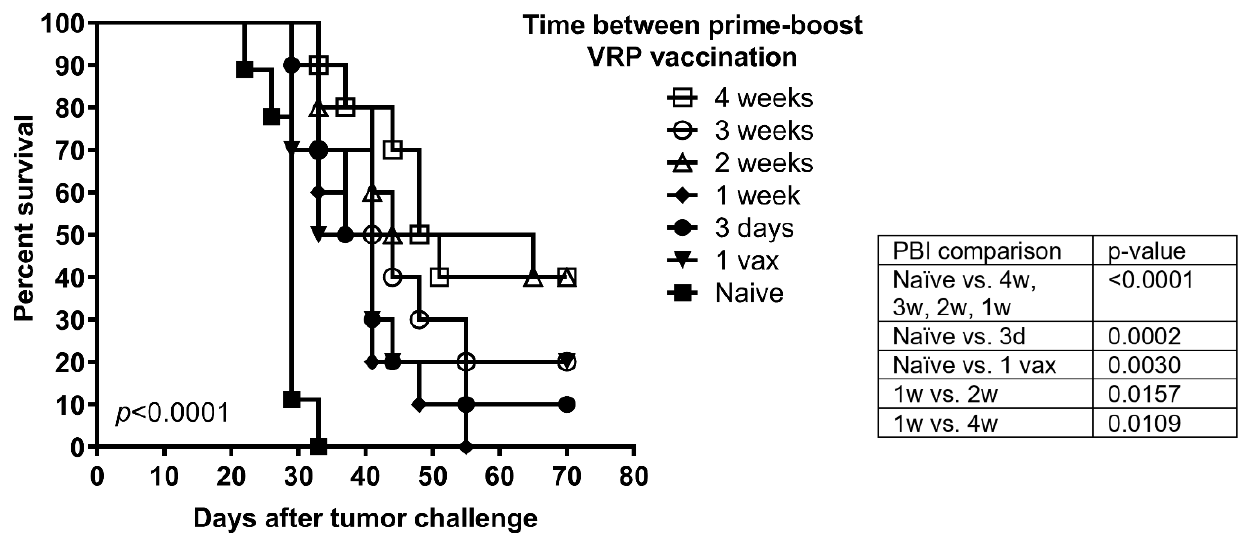
Figure 3. Longer intervals between prime and boost lead to enhanced memory T cell recall responses to tumor several months post vaccination. C57BL/6 mice ( n = 10/group) were immunized with HPV16 E6E7 VRP according to the vaccination schedule in Figure 1. Four months after the last vac- cination, mice were challenged with 5 × 10 5 C3.43 tumor cells s.c. in the flank to analyze memory recall response induced after varying prime-boost intervals. Median survival of 4 wk PBI was